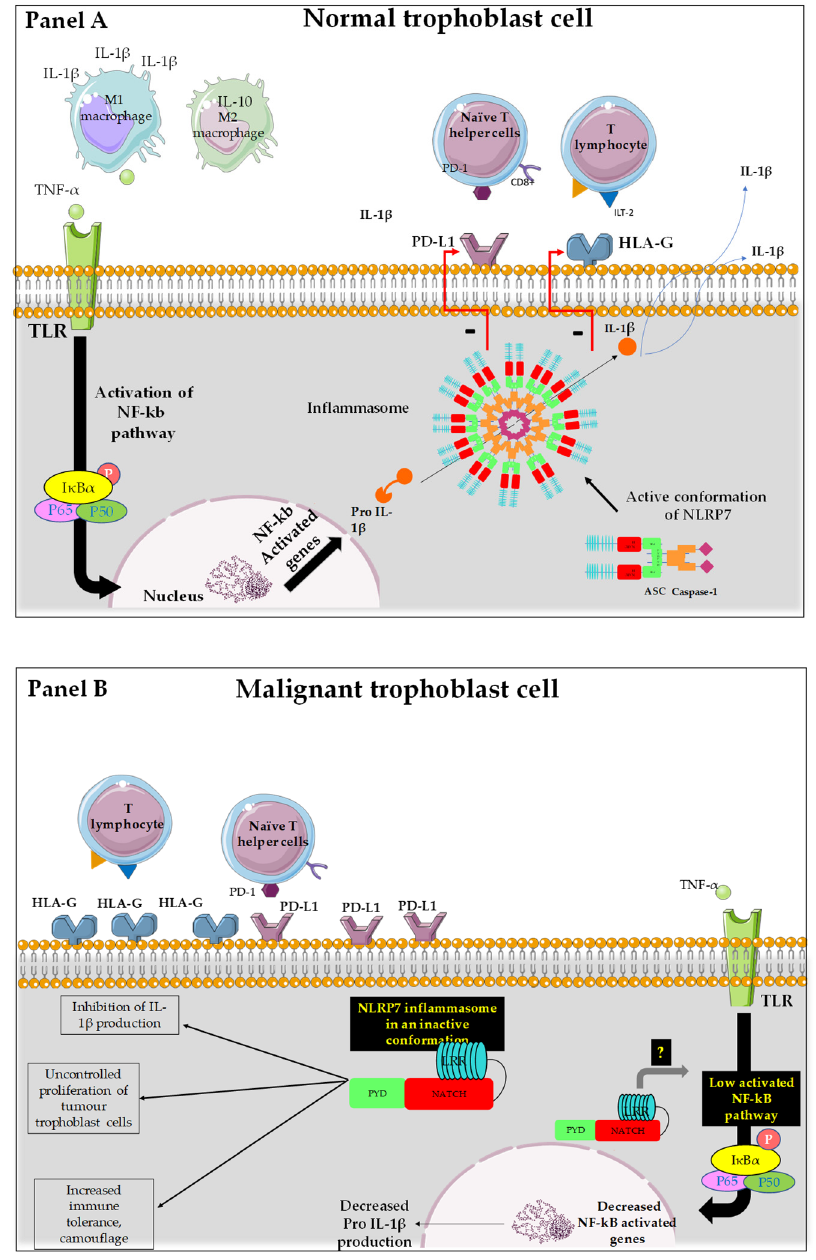
Figure 3. Representation of the mode of function of NLRP7 in normal and tumor trophoblast cells. ( A ): NLRP7 is normally expressed in trophoblast cells and functions in an inflammasome- dependent manner to allow maturation of pro-IL-1 β to IL1 β . The transcription of pro-IL-1 β depends on the activation of NF- κ B that translocates into the nucleus and increases the transcription of pro-IL-1 β . NLRP7 also regulates the expression of HLA-G and PD-L1 to allow normal tolerance of the trophoblast by the maternal immune system and favors the polarization of macrophages to M1 subtype. All these processes allow the protection of the fetus and ensure the progress of the pregnancy. ( B ): In malignant trophoblast cells, NLRP7 is overexpressed and functions in an inflammasome-independent manner. NLRP7 in turn mediates the increase in HLA-G and PD-L1 expression. This exacerbates maternal immune tolerance and camouflage of the tumor cells, creating a favorable, ant—inflammatory environment for tumor growth. NLRP7 overexpression mediates the excessive proliferation of trophoblast cells and suppresses their differentiation, allowing for further migration and invasion that ultimately leads to metastasis of distinct maternal